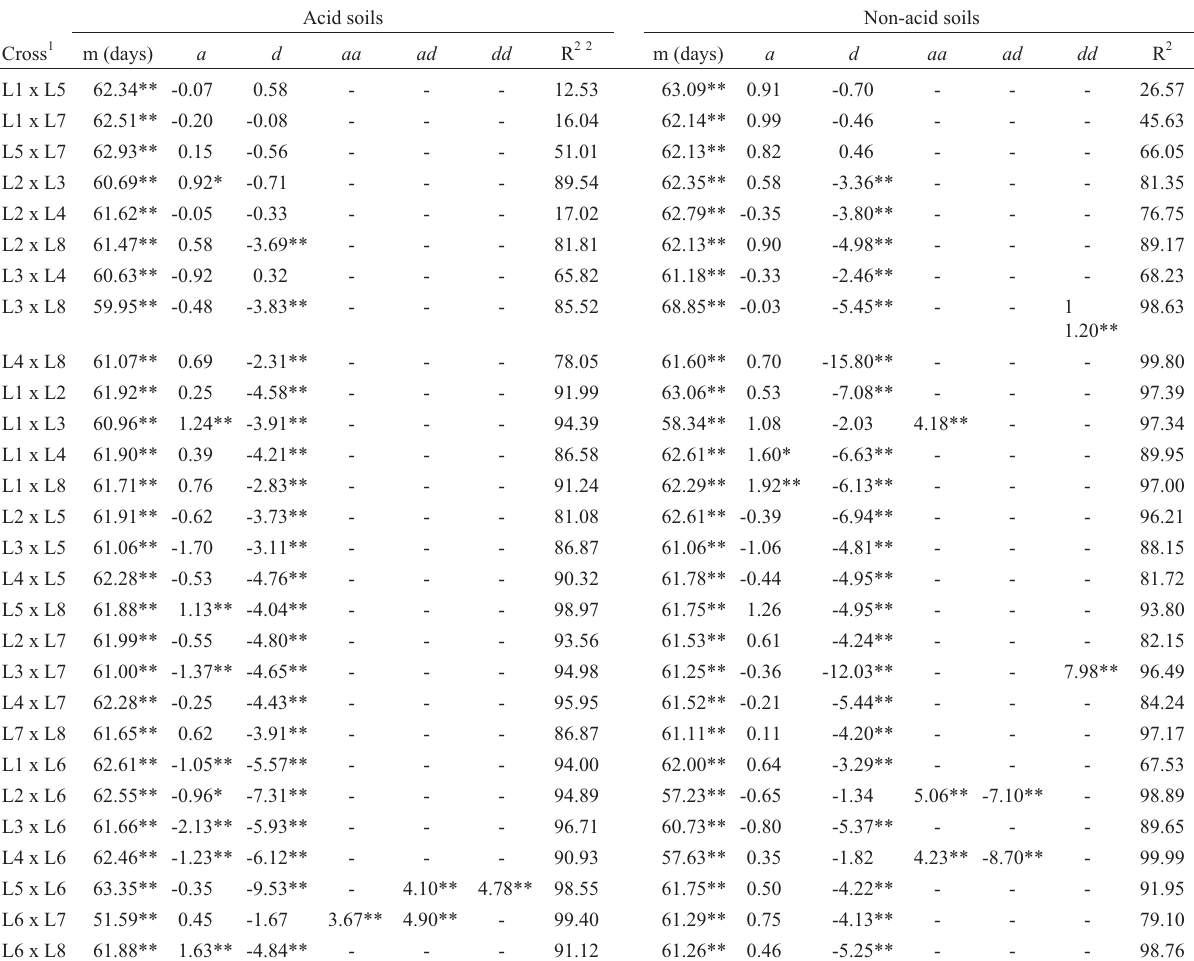
Table5 -Estimatesofmean(m),additive( a ),dominance( d )anddigenicepistatic( aa , ad , dd )effectsformaizemid-silk,evaluatedinfouracidsoilandin two non-acid soils environments in Brazil and